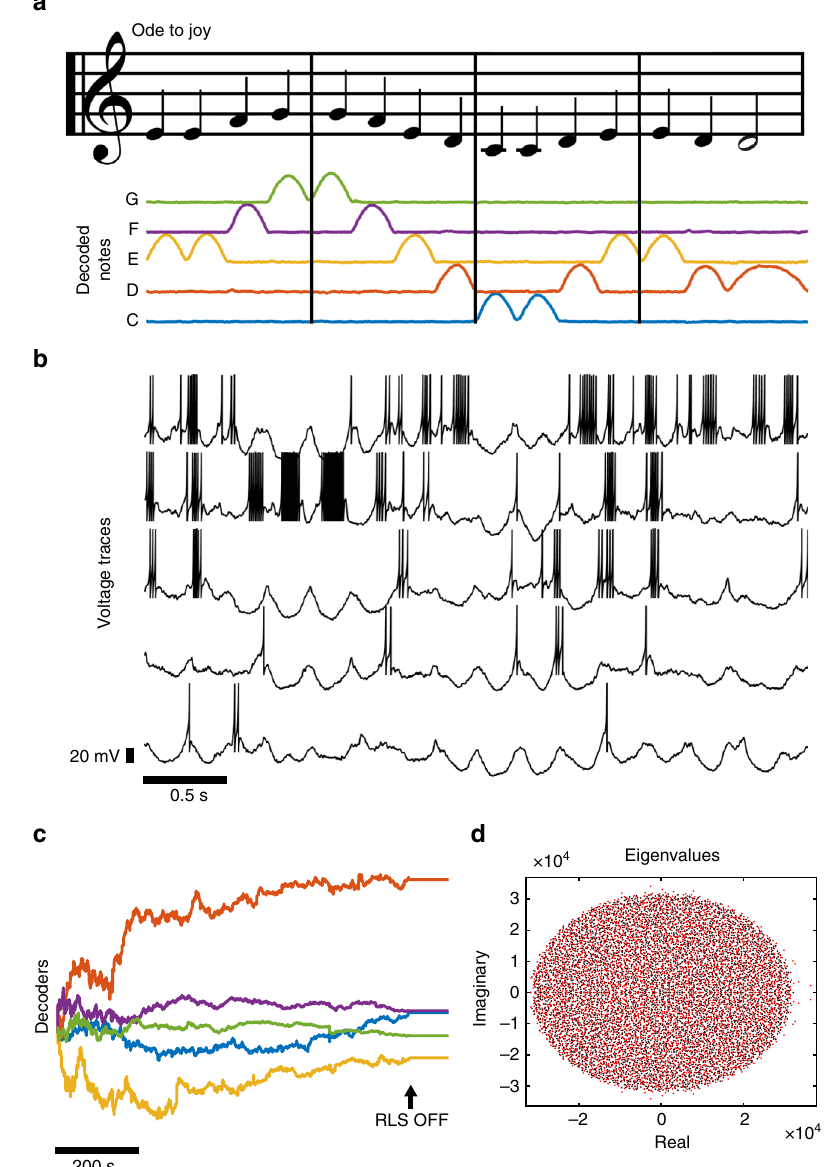
Fig. 3 Using spiking neural networks for pattern storage and replay with FORCE training. a The notes in the song Ode to Joy by Beethoven are converted into a continuous 5-component teaching signal. The sheet music has been modi fi ed from Mutopia ( 76 ) by Wilten Nicola. The presence of a note is designated by an upward pulse in the signal. Quarter notes are the positive portion of a 2 Hz sine wave form while half notes are represented with the positive part of a 1 Hz sine wave. Each component in the teaching signal corresponds to the musical notes c – g . The teaching signal is presented to a network of 5000 Izhikevich neurons continuously from start to fi nish until the network learns to reproduce the sequence through FORCE training. The network output in a is after 900 s of FORCE training, or 225 applications of the target signal. For 1000s of simulation time after training, the song was played correctly 205 times comprising 820 s of the signal (Supplementary Figs. 15, 16). b Five randomly selected neurons in the network and their resulting dynamics after FORCE training. The voltage traces are taken at the same time as the approximant in a . c The decoders before (1 < t < 900) and after ( t > 900) FORCE training. d The resulting eigenvalues for the weight matrix G ω 0 ij þ Q η i ϕ j before (black) and after (red) learning. Note that the onset to chaos occurs at G ≈ 10 3 for the Izhikevich network with the parameters we have